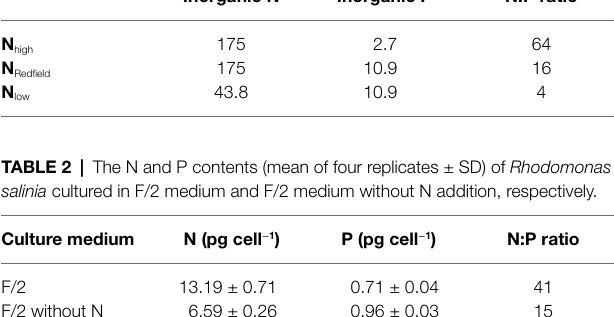
TABLE 1 | The nitrate (N) and phosphorus (P) concentrations ( μ mol L − 1 ) of the culture medium used for Lepidodinium sp. culture mediums. Inorganic N